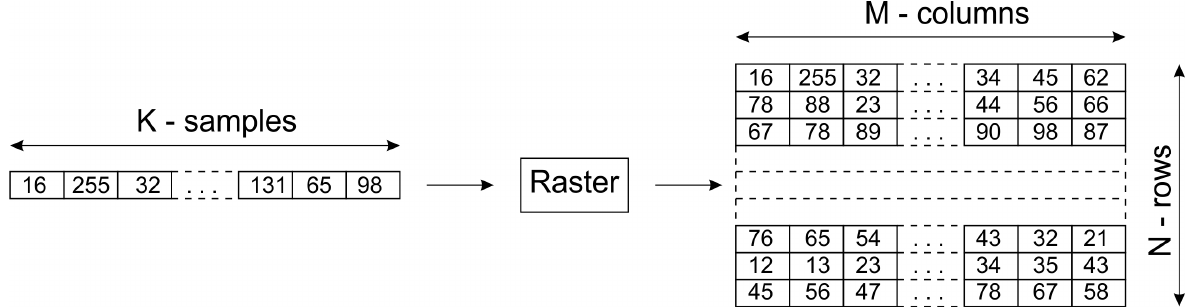
Figure 2. An operation mechanism of image reconstruction (raster).